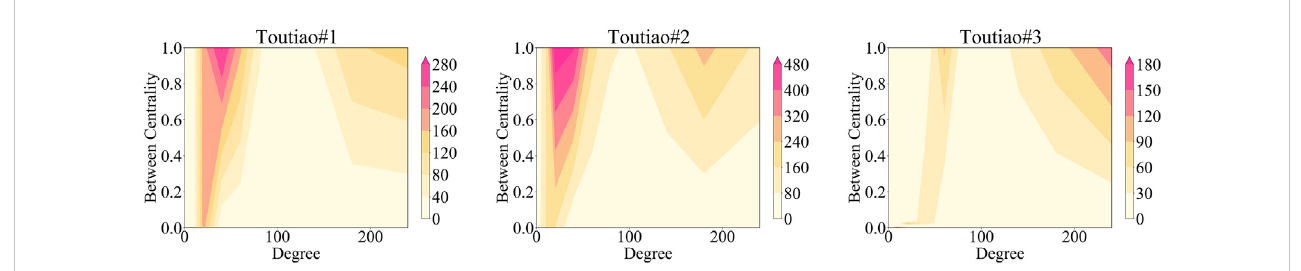
FIGURE 4 Illustration of heatmap distribution modulation consisting of two variables: node degrees and edge between centrality.